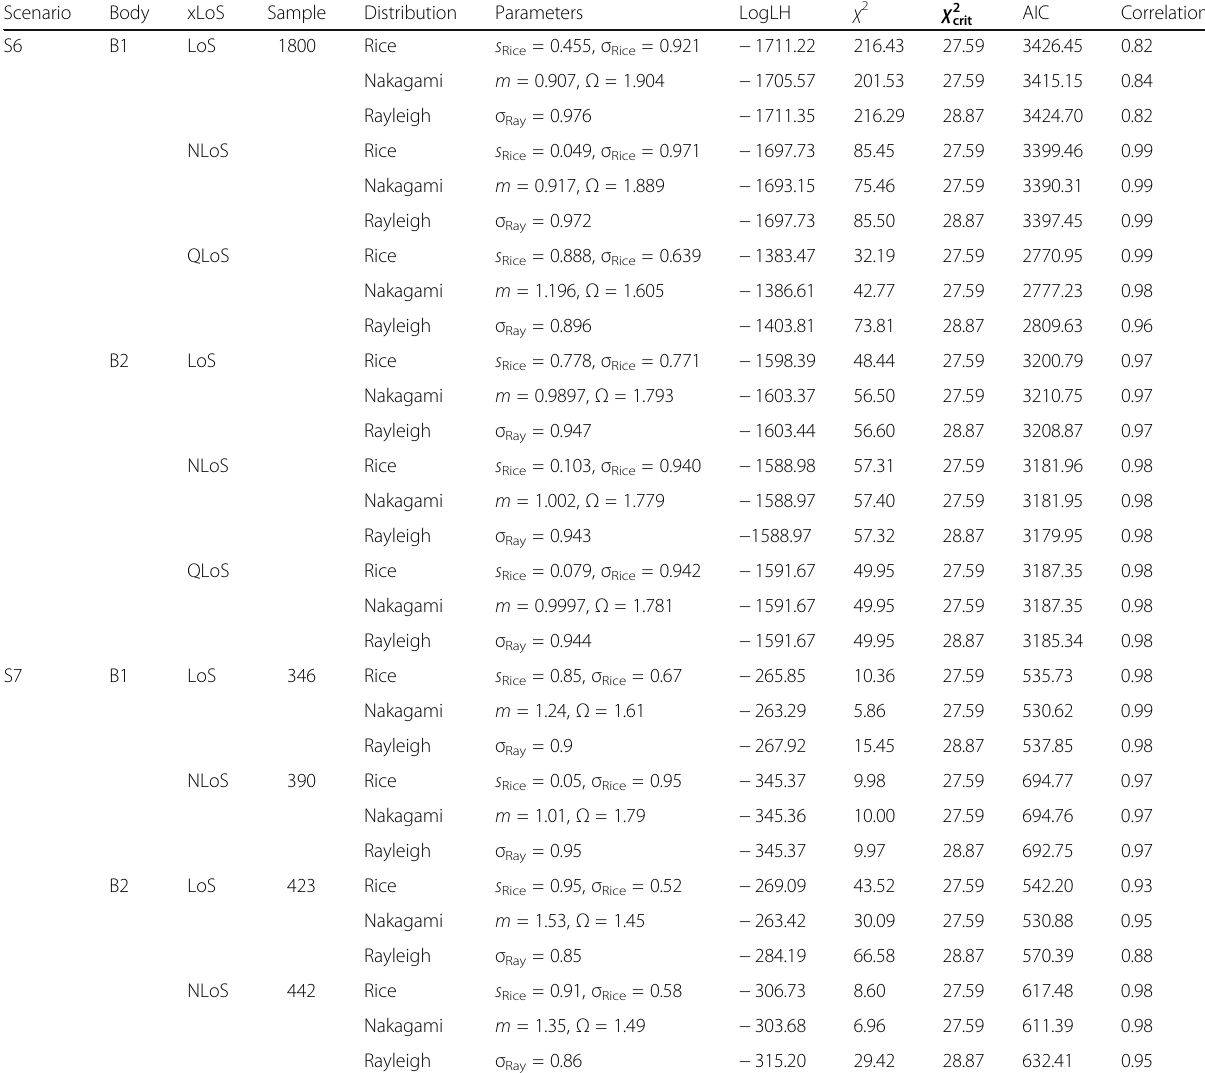
Table 7 Overview of distribution fitting for multipath component in XP channel, scenario S7 ( χ 2 and 28.87 for